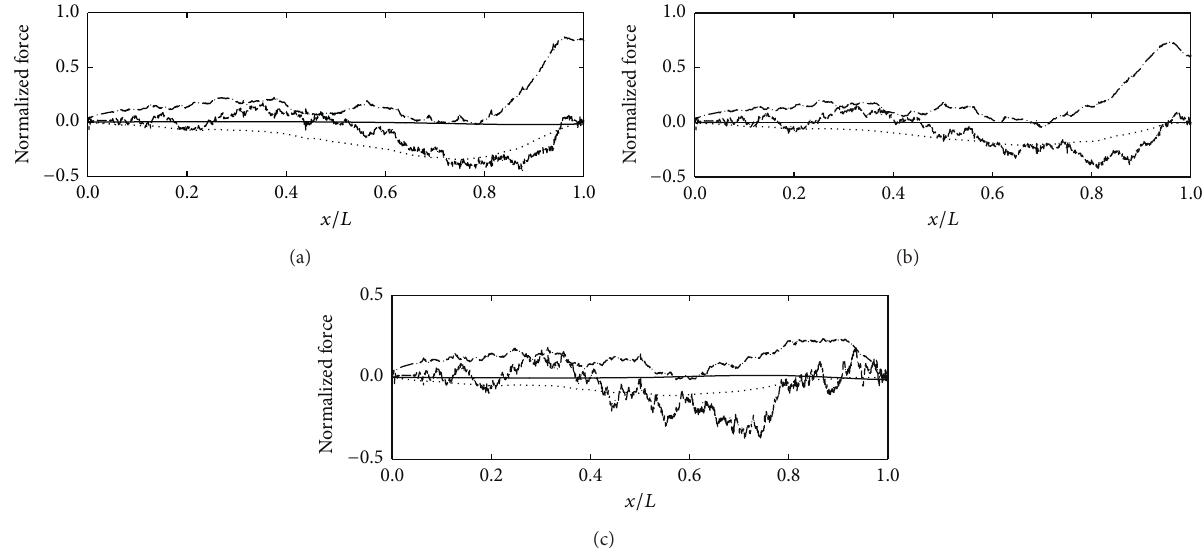
Figure 10: Normalized force under the equivalent moving loads with the initial speed given by 𝜏 = 0.5 . 𝛽 = 0.03 . (a) 𝜆 = 1 , (b) 𝜆 = 0 , and (c) 𝜆 = −1 . Dashed line: inertia force; dotted dashed line: Coriolis force; dotted line: centrifugal force; solid line: tangential force.